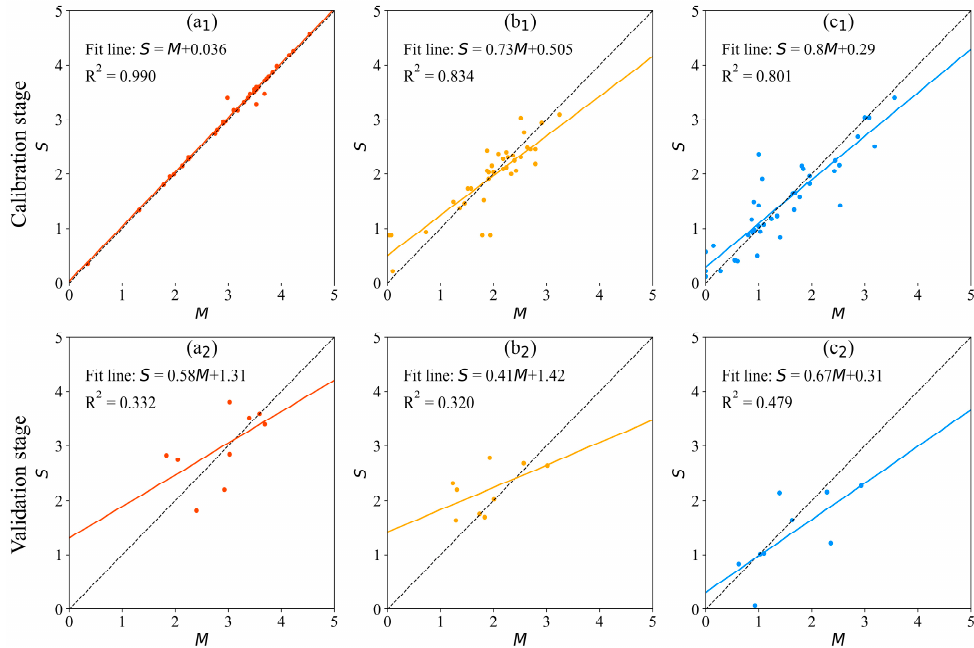
Figure 4. The performance of the GA-BP models. M : measured values; S : simulated values. Subgraphs ( a – c ) represent P-SWI , Z-SWI , and B-SWI , respectively. Subscripts 1 and 2 represent the calibration stage and the validation stage, respectively.